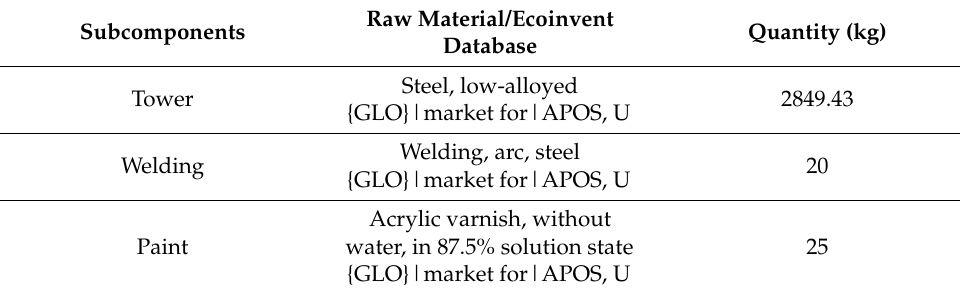
Table A4. Tower inventory and matching Ecoinvent records.